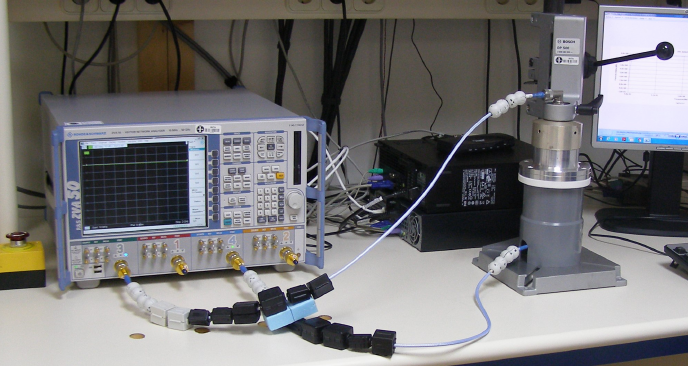
Figure 14. Measurement setup according to ASTM D4935